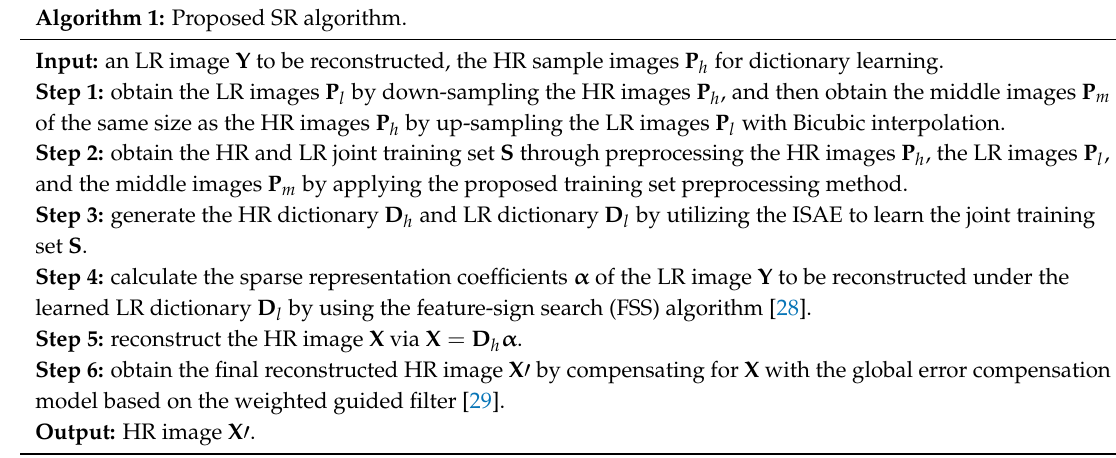
Algorithm 1: Proposed SR